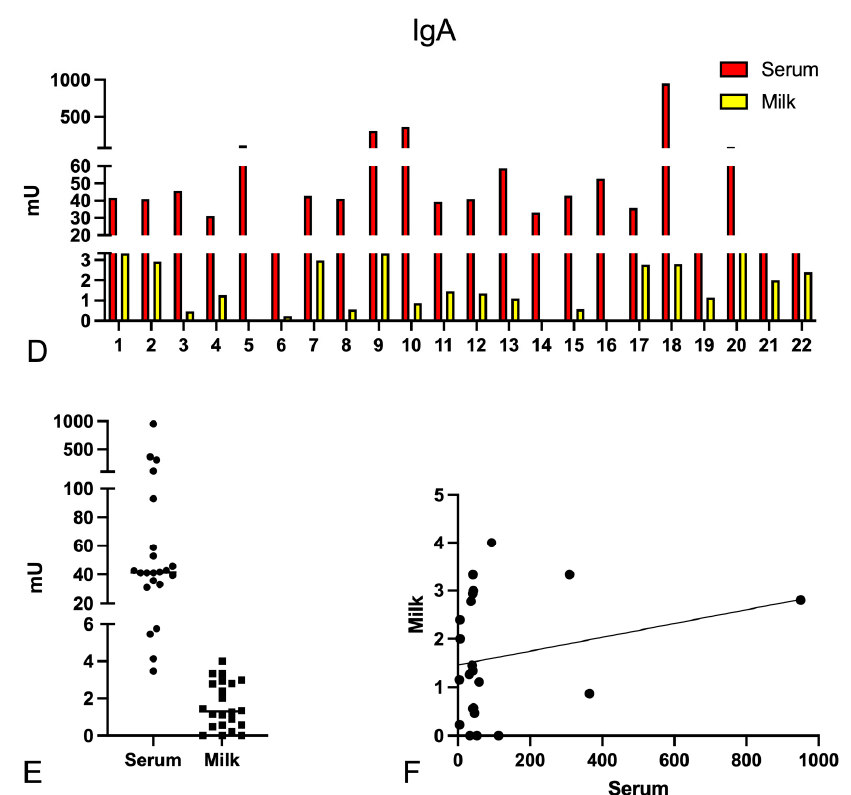
Figure 1. Measurement of anti-Spike IgG and IgA levels in serum and milk of vaccinated and lactating women. Serum and milk samples of the enrolled women ( n = 22) were quantified for the presence of anti-S IgG ( A – C ) and IgA ( D – F ). Despite a wide variability, Ig levels appeared to be greater in the serum as compared to the milk ( B,E ). A statistically significant correlation was found between serum and milk IgG levels (Pearson test, p < 0.0001, r 2 = 0.62) ( C ), whilst no correlation was found for IgA ( F ).